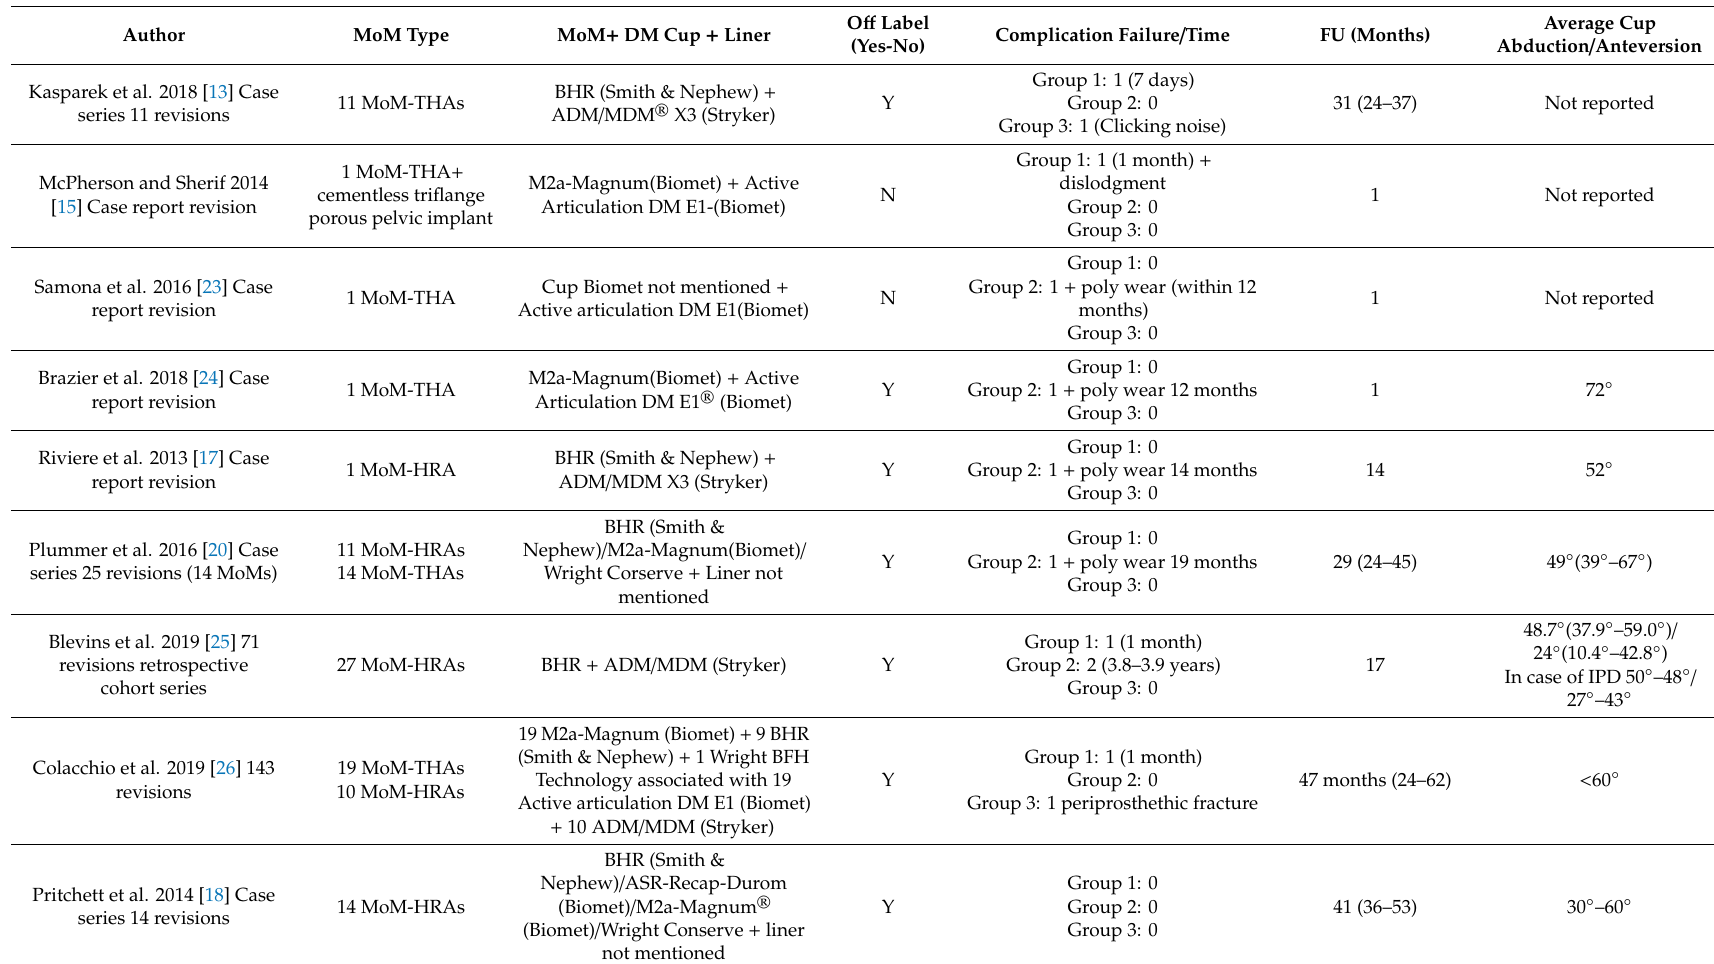
Table 1. The scientific literature that meets our